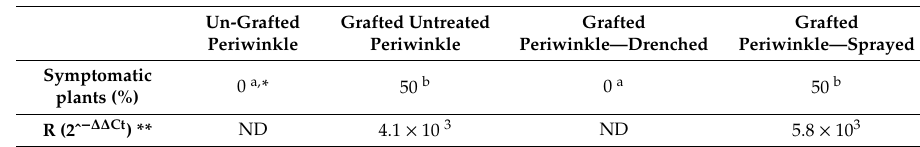
Table 3. The e ff ect of di ff erent application techniques of 4-quinolinecarboxaldehyde (QC) and 5-hydroxymethyl-2-furaldehyde (HMF) on phytoplasma symptoms and titer in grafted with phytoplasma infected plants and un-grafted periwinkles 12 weeks post grafting. Each